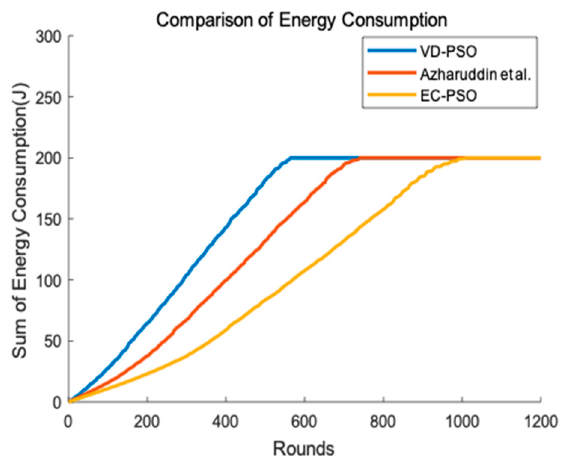
Figure 8. Energy consumption of the network.